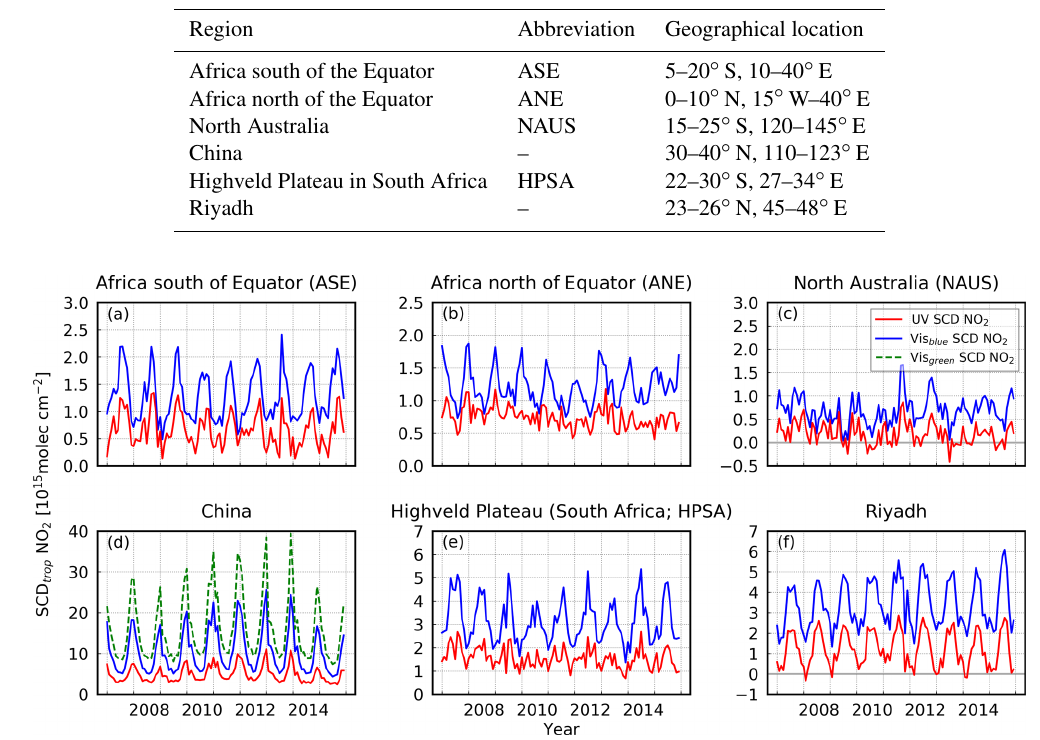
Figure 11. Time series 2007–2015 of tropospheric NO 2 SCDs for the UV (red line), vis blue (blue line), and vis green (green line, China only) spectral range for different regions. Note the different y axes. The vertical lines indicate January of the individual years. (a–c) Biomass burning regions and (d–f) regions with high anthropogenic air pollution.